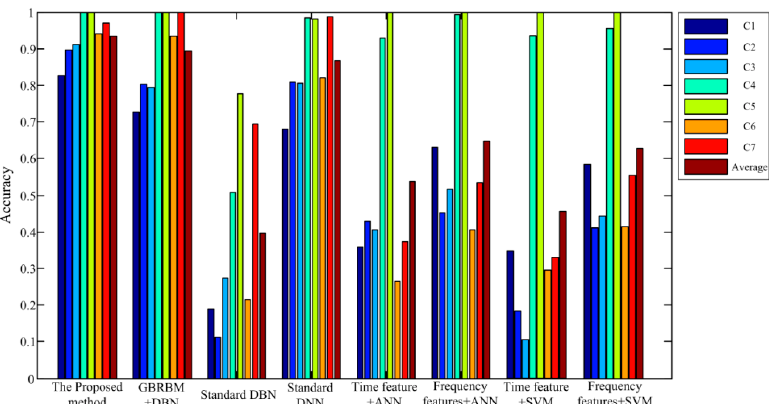
Figure 6. Diagnosis accuracy for all seven gear pitting conditions and the averaged accuracy under 500 rpm-500 Nm working condition.